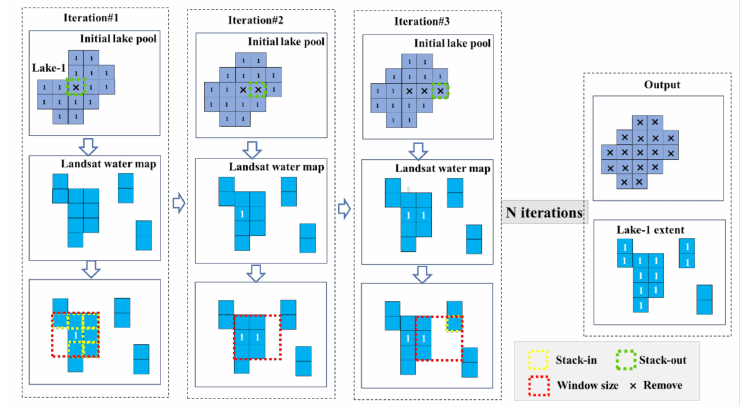
Figure 2. The graphical iteration processing for lake